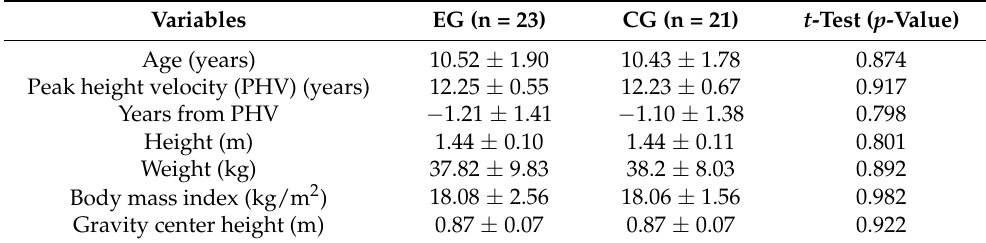
Table 1. Subjects’ Table 1. Subjects’ Characteristics.